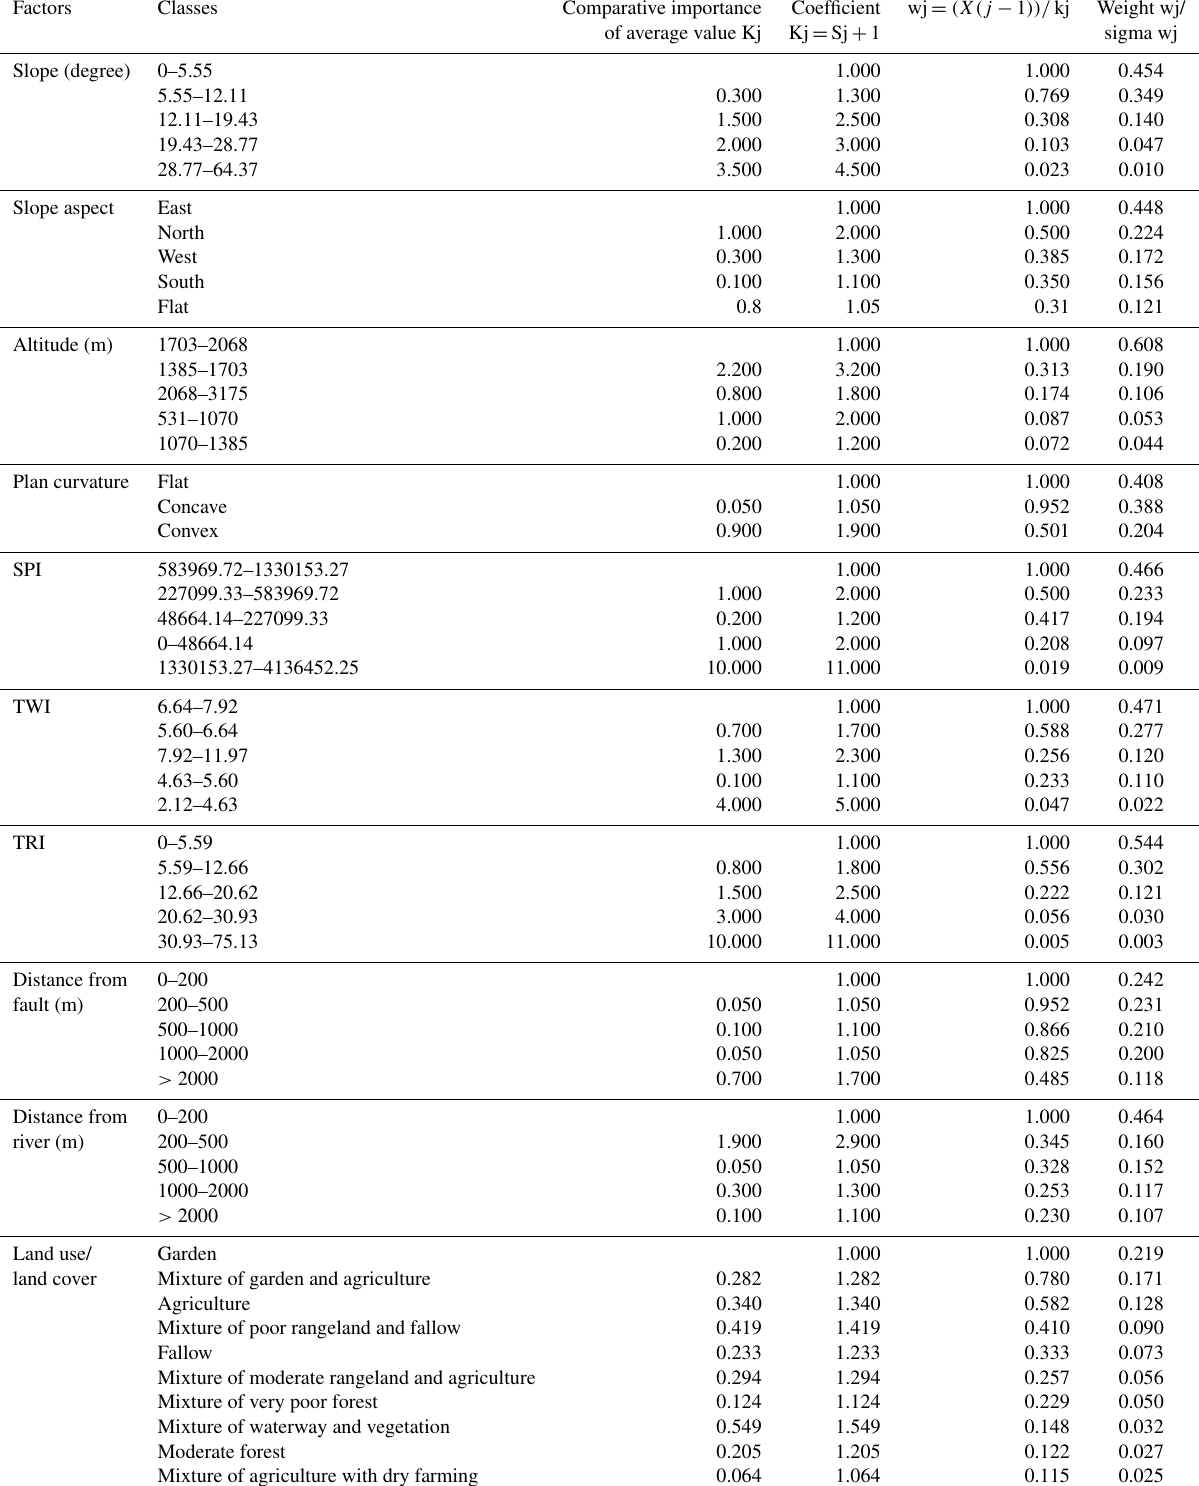
Table 2. Spatial correlation between the conditioning factors and spring locations using the SWARA